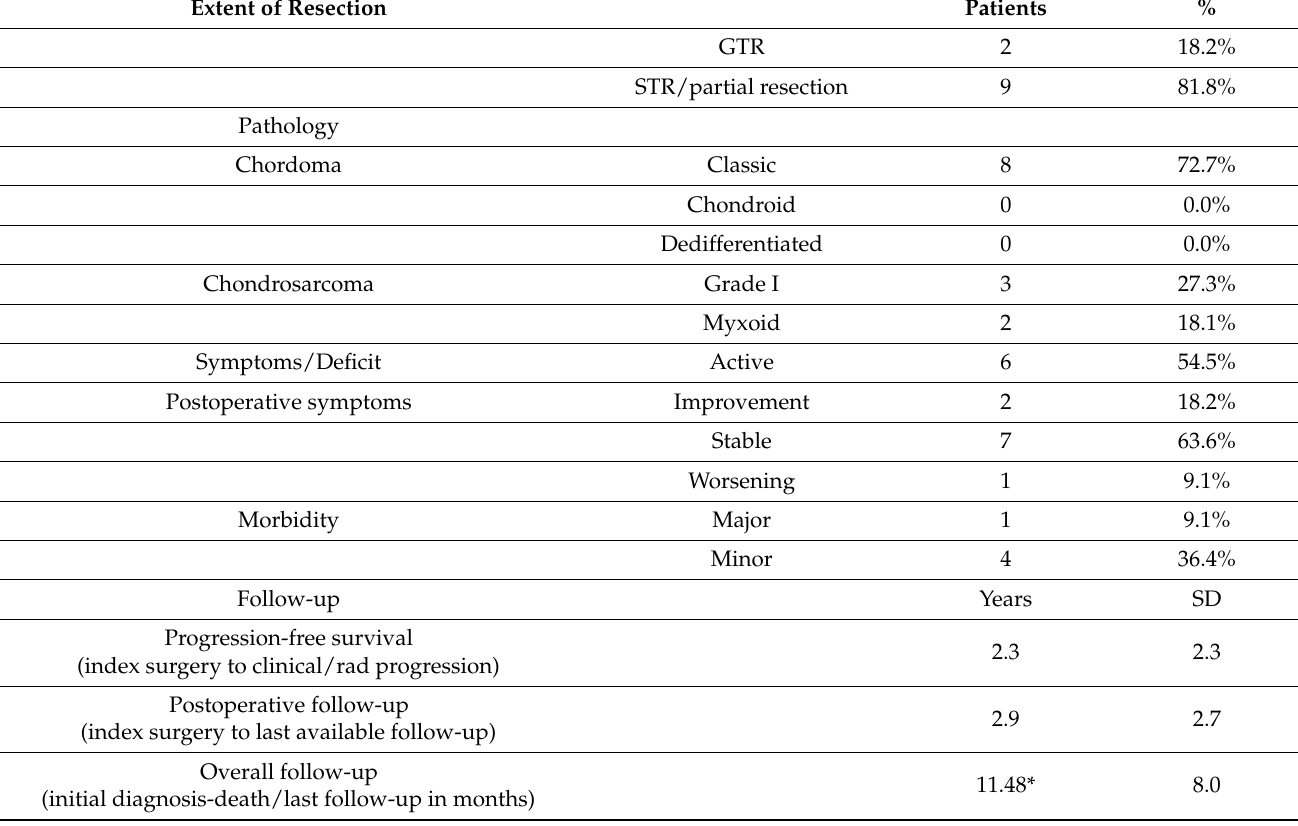
Table 4. Summary of resection, pathology, and follow-up results.